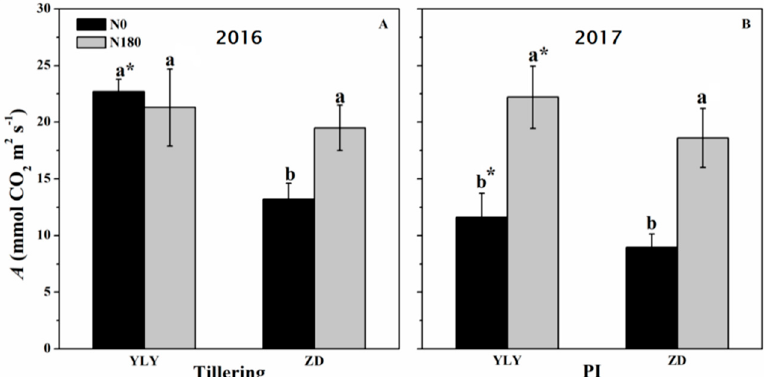
Figure 6. Net photosynthesis rate ( A ) of YLY and ZD under different N treatments during tillering ( A ) and panicle initiation stage ( B ) in 2017. Data with different letters represents significant difference ( p < 0.05) between N treatments within cultivar; * represents significant difference ( p < 0.05) between YLY and ZD under the same N treatment.Vertical bars represent S.D. of the mean ( n = 3) where these exceed the size of the symbol.